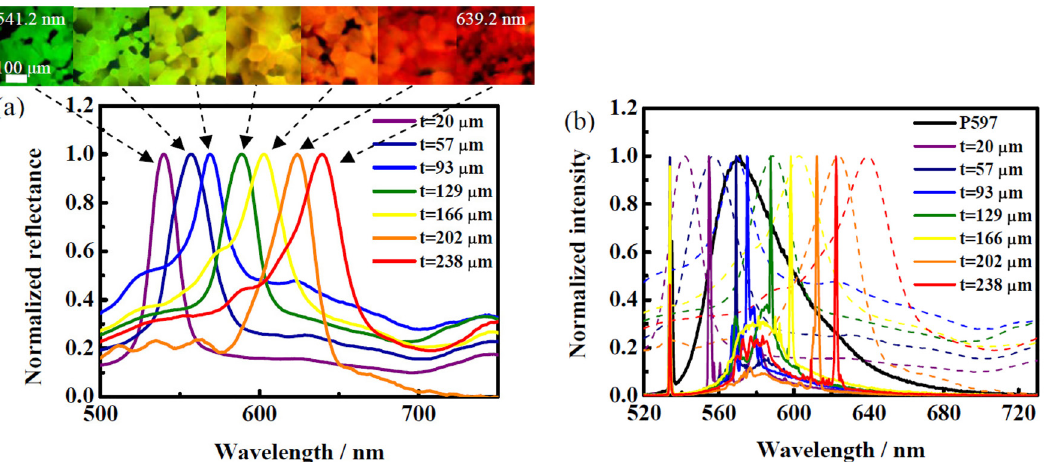
Figure7: (a)MeasuredreflectionspectraandcorrespondingR-POMBPimagesfortheDDBPwedgecellat y =2.5 – 28.5mm( t =20 – 238 μ m)at 54.5 ° C.(b)Measuredlasingspectra(solidcurveswithsharppeaks)andcorrespondingre fl ectionspectra(dottedcurves,sameasthoseshown in (a)) for the DDBP wedge cell measured at y = 2.5 – 28.5 mm ( t = 20 – 238 μ m) at 54.5 ° C. The black solid curve is the fl uorescence emission spectrum of the laser dye [65].